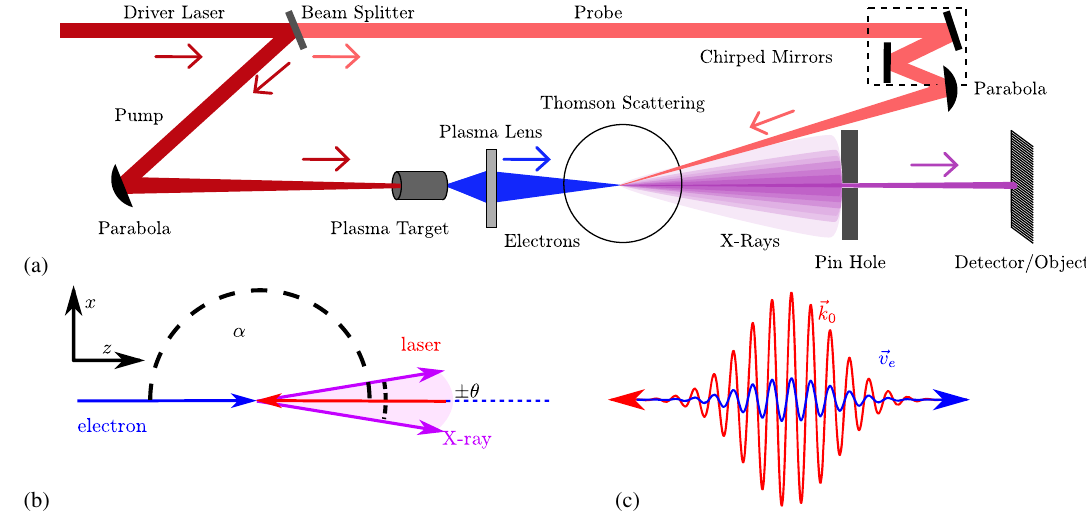
FIG. 1. Schematic of the all-laser-driven x-ray source combining LWFA and TS (a). Head-on geometry of the Thomson process in the particle (b) and classical image